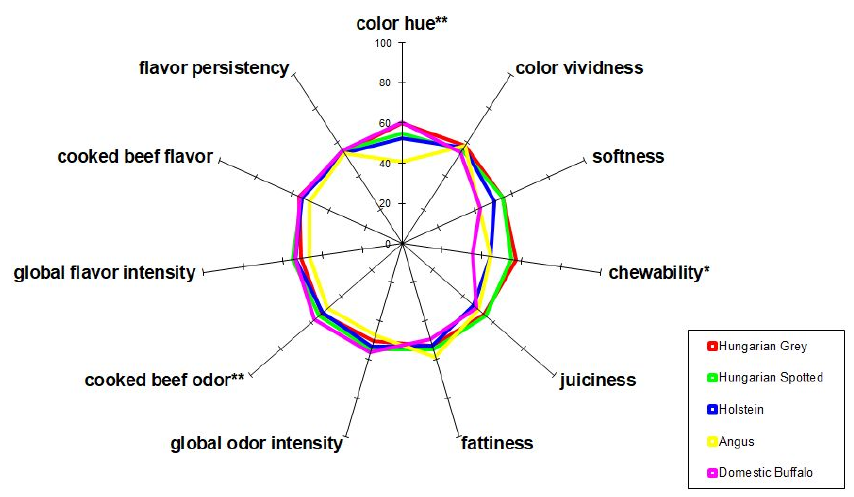
Figure 8. Sensory profile of the meat samples. Key: * significant, ** very significant.